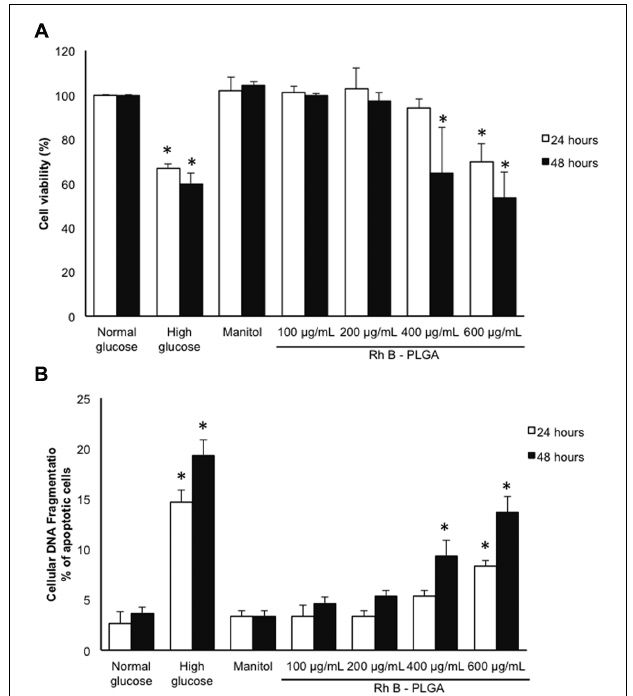
FIGURE 3 | (A) Cytotoxicity analyses results by MTT assay after 24 and 48 h incubation with RhB-loaded PLGA NPs. (B) % of cardiomyocyte apoptosis after 24 and 48 h incubation with RhB-loaded PLGA NPs as assessed by the cellular DNA fragmentation assay. Values are the mean ± standard deviation from three independent experiments. ∗ P < 0.05 vs. normal glucose.